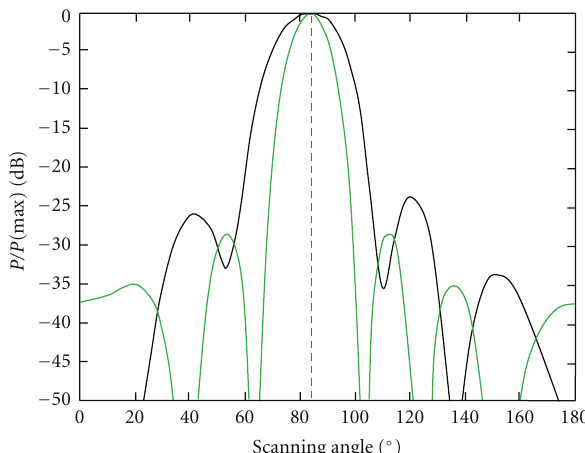
Figure 12: The beam pattern pointed towards the useful signal with the angle of 83 degrees.